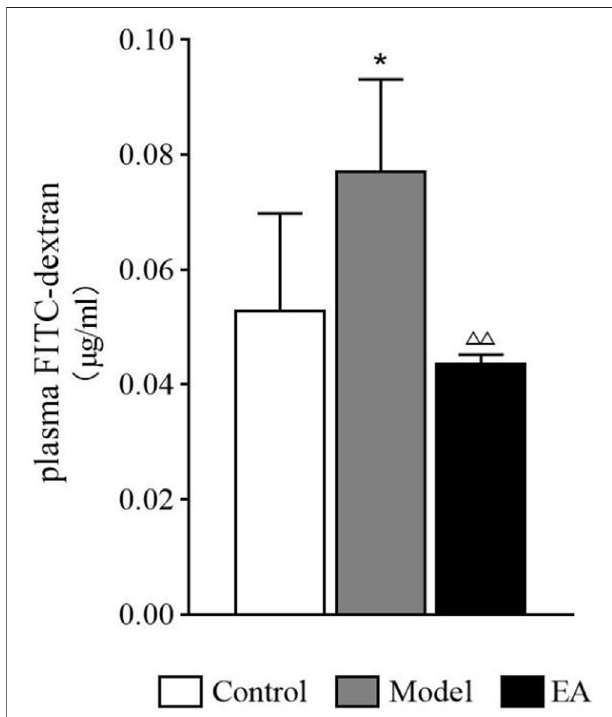
FIGURE10| Concentrationsofplasma FITC-dextran. One-wayANOVA indicatedthattheconcentrationsofplasmaFITC-dextranshowedasigni fi cant increase in the model group and a signi fi cant decrease in the EA group. Bar: mean ± SE, n = 4, * p < 0.05, versus the control group; △△ p < 0.01, versus the model